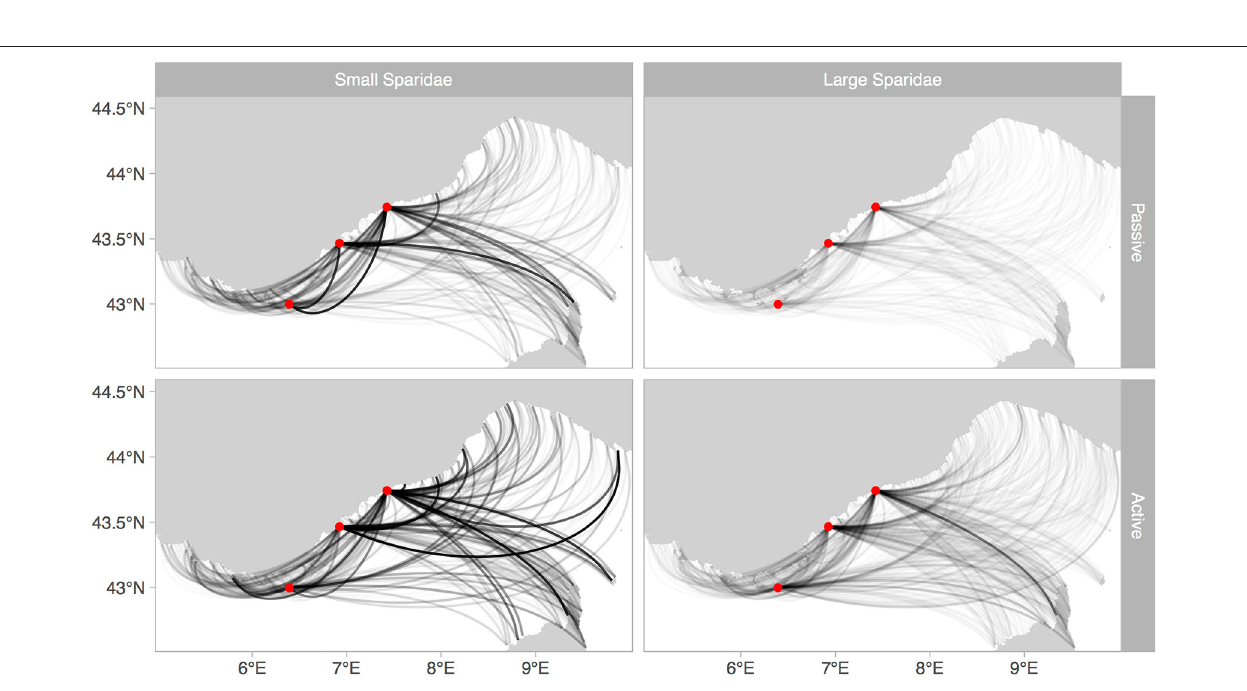
Frontiers in Marine Science | www.frontiersin.org